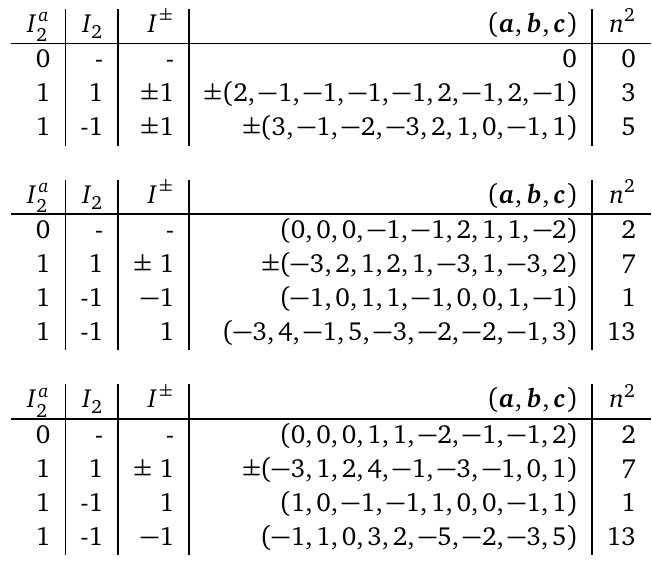
, I , I ± ) , for L mod 3 = 0,1,2 (from top 2 2 + a + a = 0, a − b ≡ L (mod 3) x y z